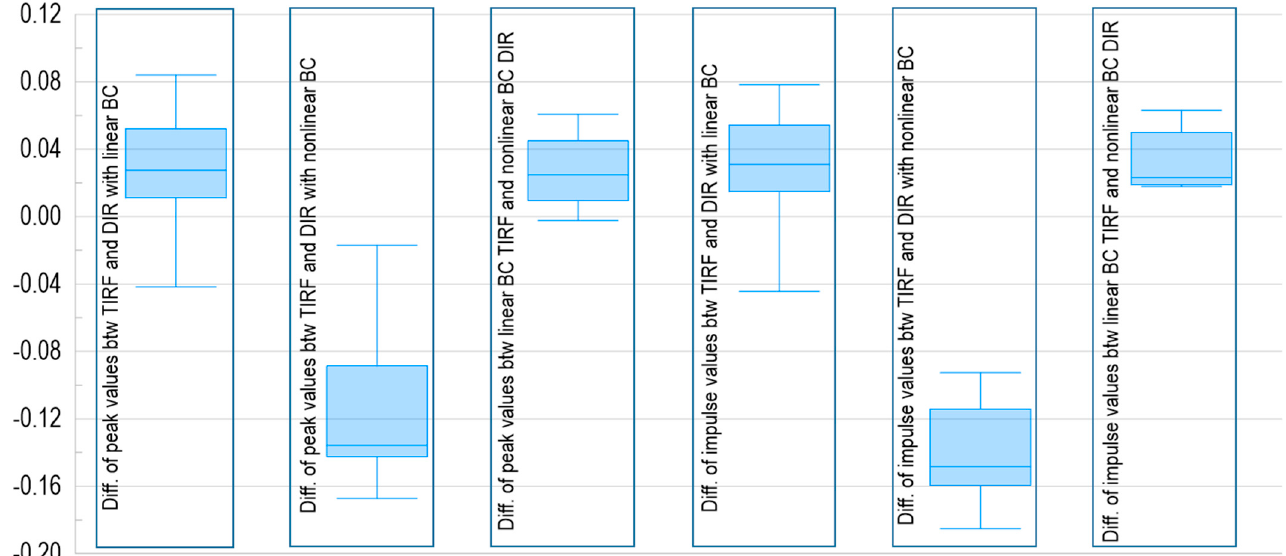
Figure 20. Reference shear and bending responses for Load A (1 × 1 load case) using TIRF and DIR for impact pressure of 5.0 ms of rise time: ( a ) Reference shear responses with linear boundary con- ditions, ( b ) Reference bending responses with linear boundary conditions, ( c ) Reference shear re- sponses with nonlinear boundary conditions, and ( d ) Reference bending responses with nonlinear boundary conditions. Table 10. Bending responses for LNG cargo containment boxes with hull structure (Model 3).